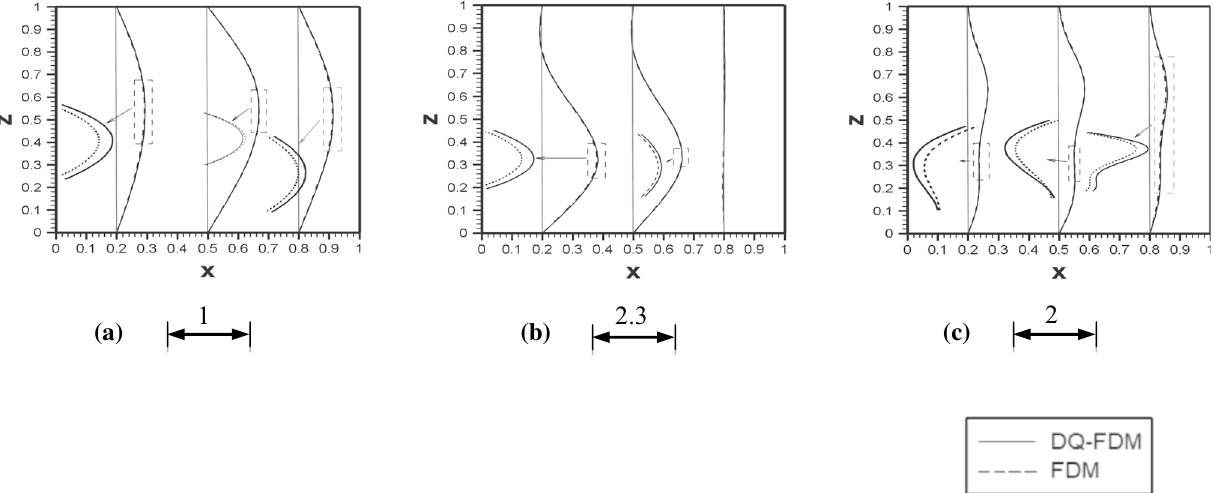
Fig. 10 A sample of comparing the distribution of the velocity of the a longitudinal ( u ), b depth ( v ) and c transverse ( w ) along the width and for passing plate through the middle of the depth (t = 0.05,